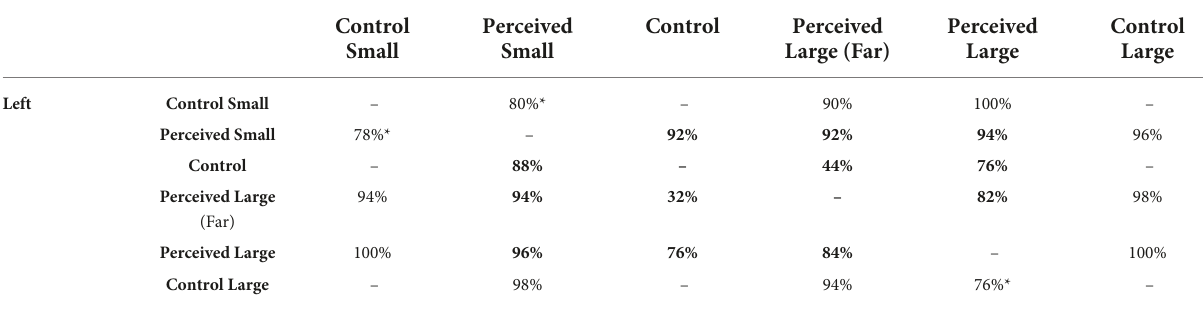
TABLE 5 Experiment 1 perceptual